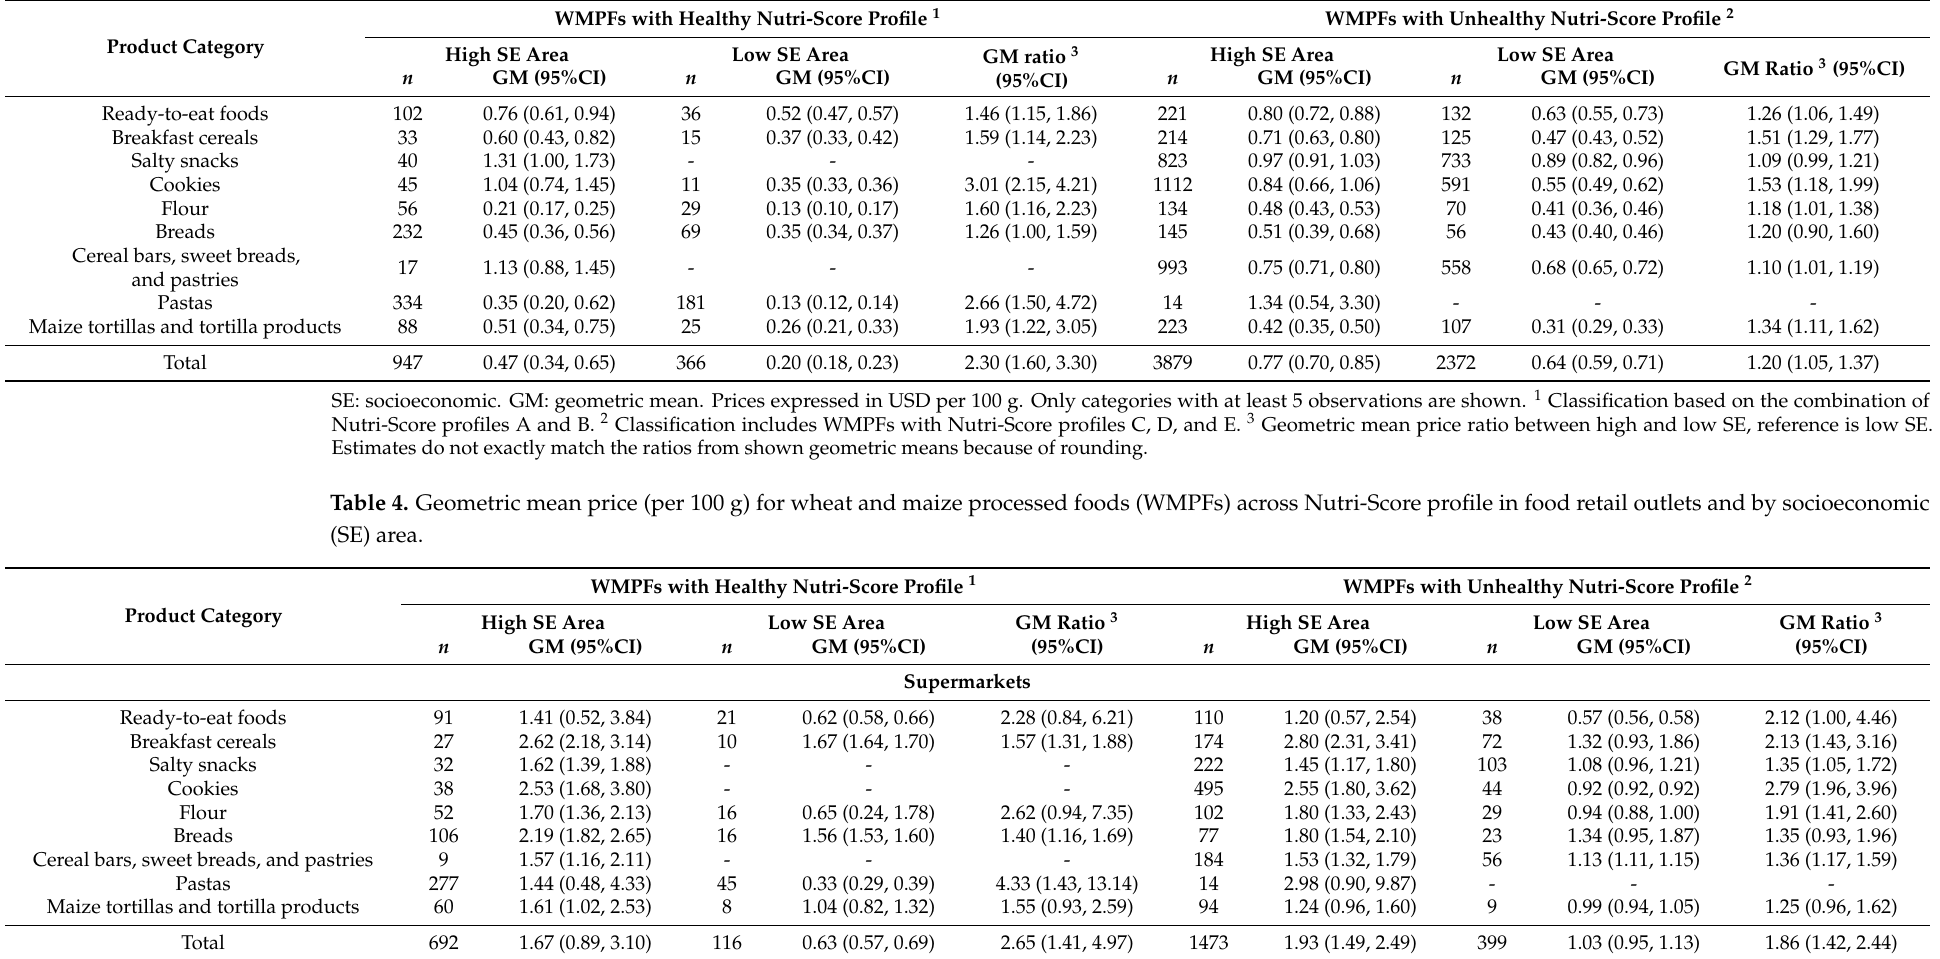
Table 3. Distribution of geometric mean price (per 100 g) of WMPF categories across Nutri-Score profiles and SE areas.